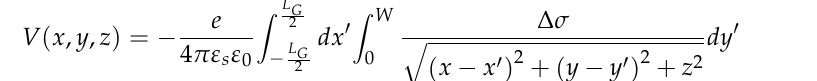
Figure 7. ( a , b ) Schematic of the InAlN/GaN HEMT before and after TFSI treatment; ( c , d ) Schematics of the polarization charge distribution of the InAlN barrier before and after TFSI treatment. Figure 7c,d show the schematic of the polarization charge distribution of the InAlN barrier before and after TFSI treatment. Initially the polarization charges of InAlN barrier under the gate region and access regions are uniform. Due to the gate bias, the polarization electric field under the gate region will be changed with the inverse piezoelectric effect, resulting in the variation of the polarization charges. As shown in Figure 7c, the polarization charge distribution is not uniform, which leads to the PCF scattering. Before the treatment, the polarization charge density is labeled as ρ 0 and can be calculated by self-consistently solving Schrodinger’s and Poisson’s equations. Owing to the converse piezoelectric effect, the gate bias can change the number of the polarization charges under the gate region (labeled as ρ G ), resulting in the additional polarization charges ∆ σ = ρ G − ρ 0 [32,33]. After TFSI treatment, the polarization charges under the access region are changed to ρ TFSI (shown in Figure 7d), leading to ∆ σ TFSI = ρ G − ρ TFSI . Because ρ TFSI is smaller than ρ 0 , ∆ σ ∆ σ . The PCF scattering potential can be written as follows [34,35]: